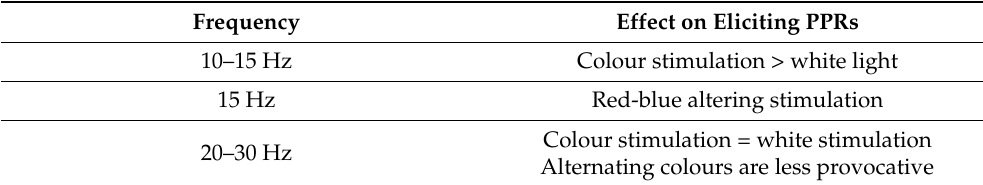
Table 3. The effect of flickering light of different colours on the evoking of epileptic seizures. Adapted from: Parra et al.